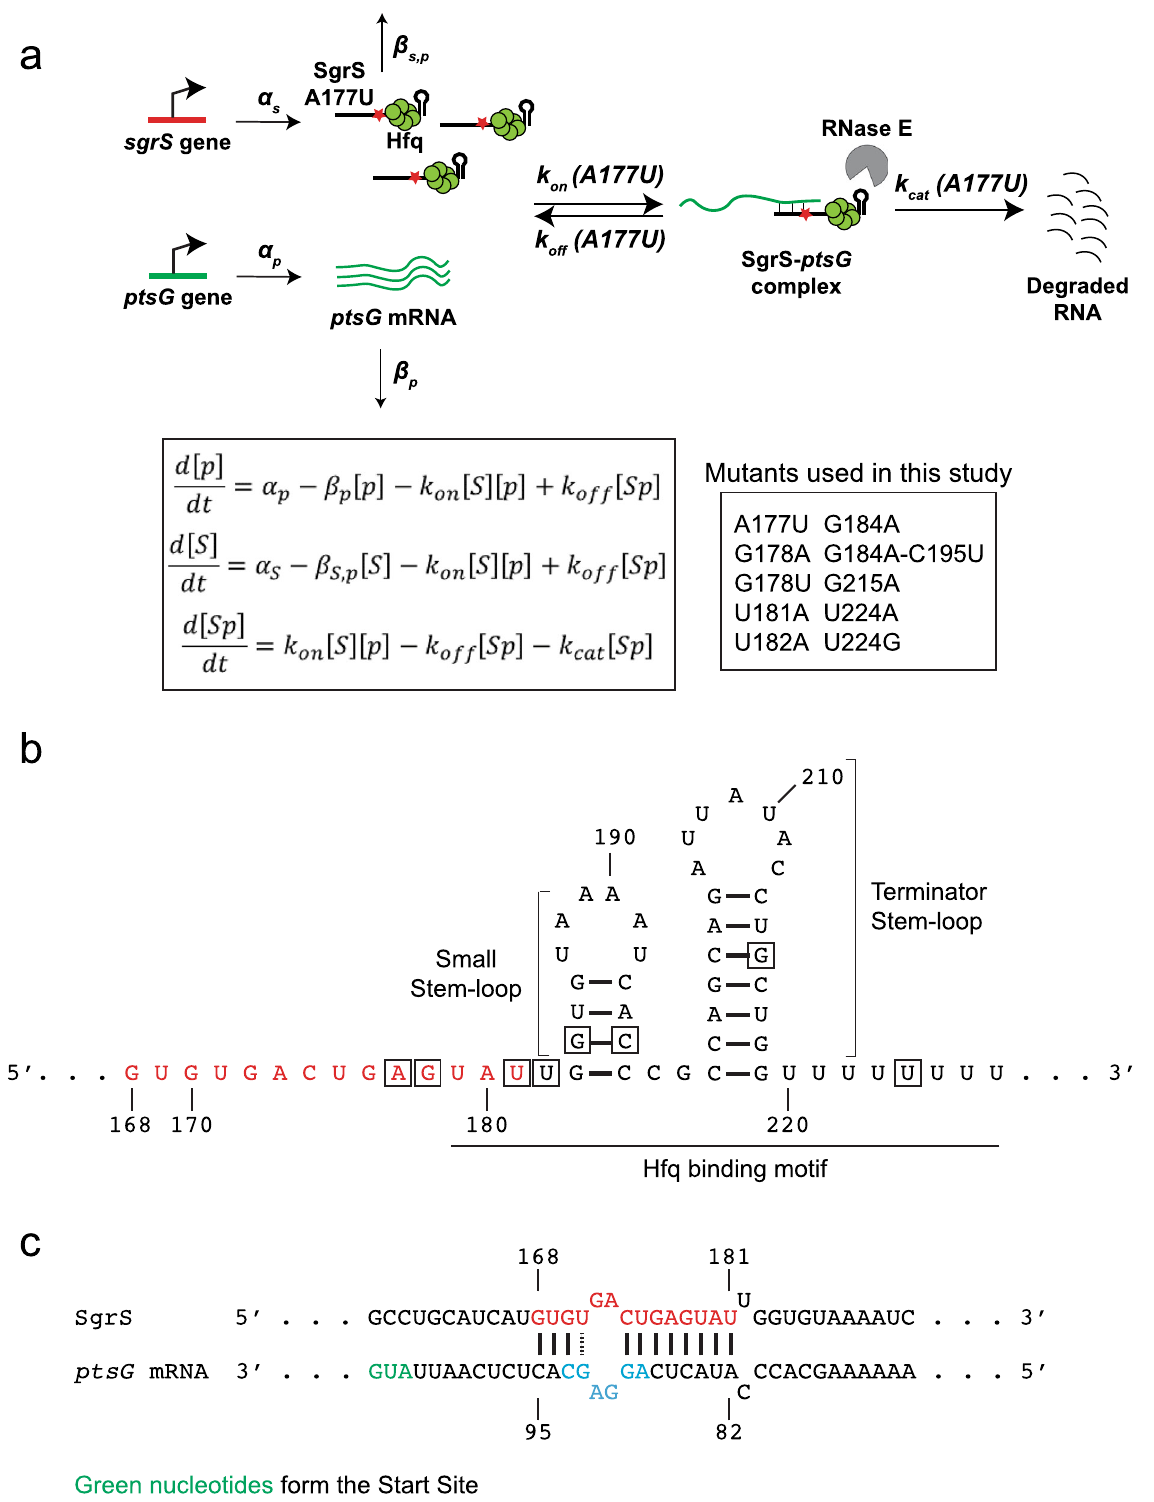
Fig. 1 Target search kinetics of SgrS. a Kinetic scheme of ptsG mRNA degradation induced by wild-type SgrS sRNA and the different SgrS point mutants. The fi gure shows one of the SgrS mutant strains, A177U. The red star represents the position of the mutation from A177 to U. The steps are described in detail in the main text and the inset shows the mutants used in this study. [ p ], [ S ], and [ Sp ] are the concentrations of ptsG mRNA, SgrS, and the SgrS- ptsG complex, respectively, in their mass-action equations. The α ’ s are the rates of transcription and β ’ s are the rates of degradation of the RNAs; k on , k off , and k cat are the rates of association, dissociation, and co-degradation, respectively. b Secondary structure of SgrS sRNA from nucleotide 168 to the poly-U tail. The nucleotide positions where mutations were made are boxed. The nucleotides involved in base-pairing with ptsG mRNA are red. c Base-pairing interaction between SgrS and ptsG mRNA showing the complementary region, start site, and ribosome binding site. NATURE COMMUNICATIONS| (2021) 12:874